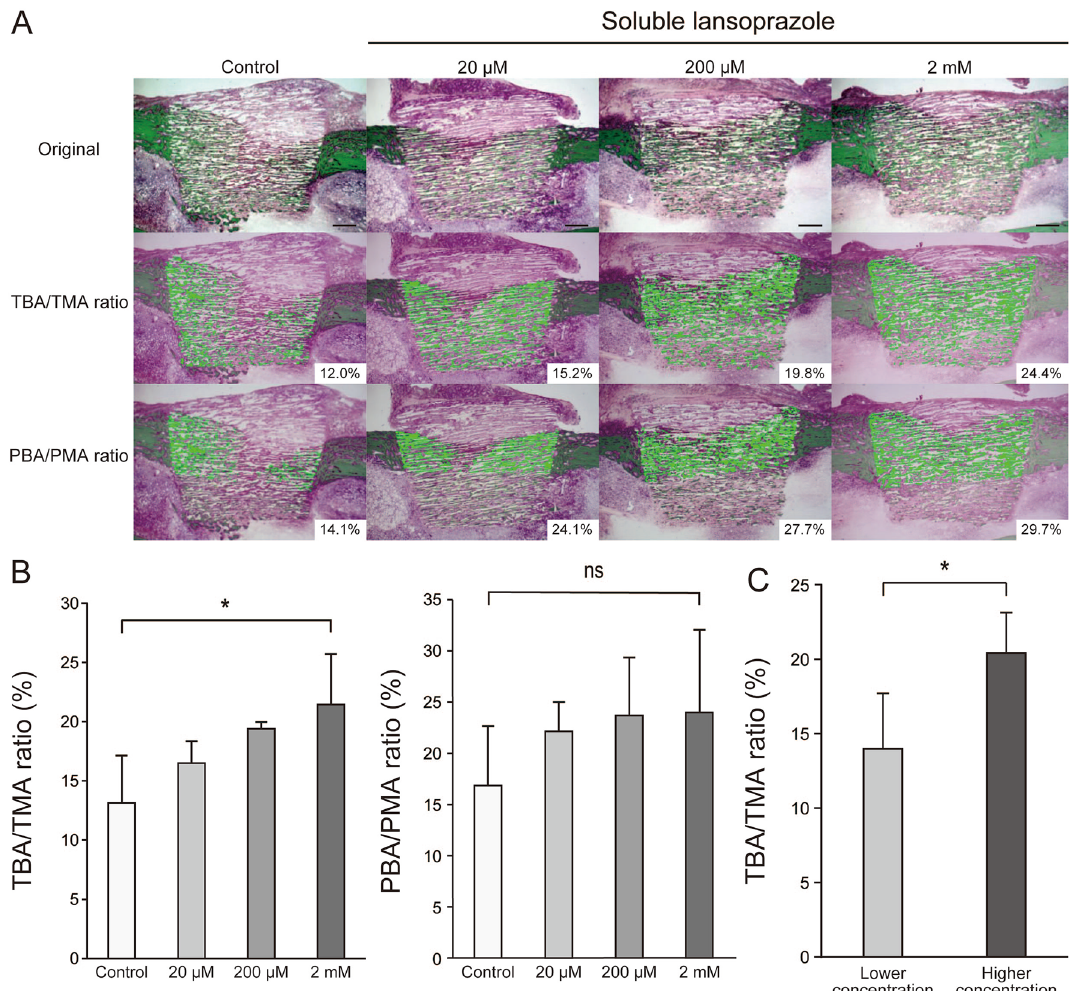
Figure 5. Soluble lansoprazole-impregnated artificial bones demonstrate the acceleration of intra-material bone regeneration. ( A ) Undecalcified bone histology of soluble lansoprazole-impregnated artificial bones embedded for four weeks in a rabbit cortical bone defect model (Villanueva-Goldner staining; upper panel). The surface area of newly formed bones within the materials was automatically measured using an image analyzer (WinROOF). The area of newly formed bones within the entire material (total bone area, TBA; middle panel) and that within the specific area of the material embedded in the cortical bone area (partial bone area, PBA; lower panel) are colored green. TMA, total material area; PMA, partial material area. Each of the area percentage ratios is indicated in the inset of the middle panel (TBA/TMA ratio) and the lower panel (PBA/ PMA ratio). ( B ) The percentage of new bone formation within the entire material (TBA/TMA ratio, left) and the specific area of the material embedded in the cortical bone area (PBA/PMA ratio, right). ( C ) The percentage of new bone formation within the entire material (TBA/TMA ratio) of the lower concentration group (control and 20 µM) and the higher concentration group (200 µM and 2 mM). In ( B , C ), the mean and SD ( n = 2 per each of three experimental subgroups and n = 6 for the control group) are indicated. * p < 0.05 by the Jonckheere- Terpstra tread test over the indicated concentration range of soluble lansoprazole solution ( B ) and by unpaired t -test ( C ). ns, not significant. Scale bars, 1